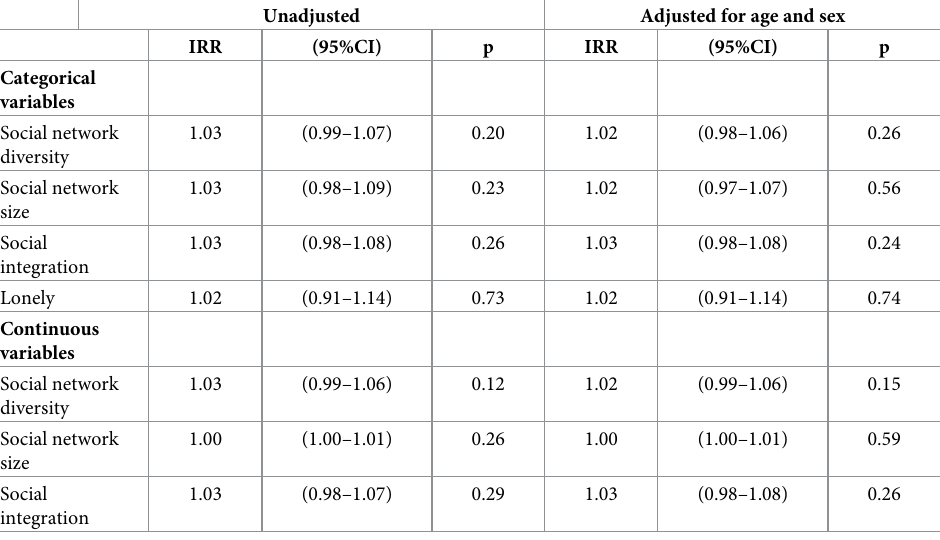
Table 4. Incidence rate ratios (IRR) regressing S . aureus colonization on individual social relationship